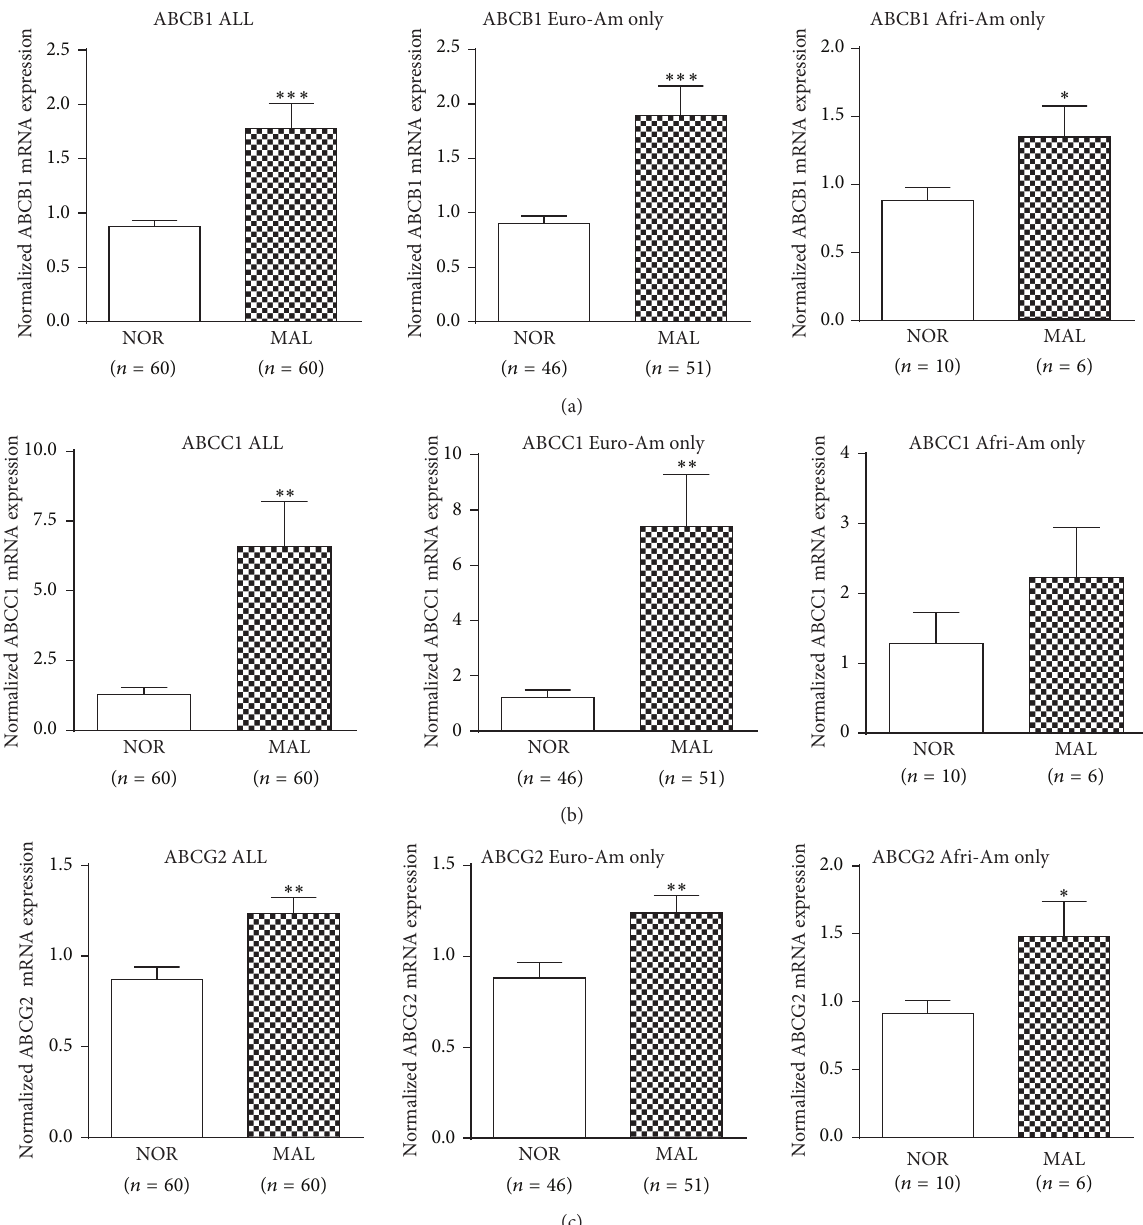
Figure 1: Comparison of ABCB1, ABCC1, and ABCG2 gene expression in normal and pancreatic cancerous tissue. The individual expression levels of the indicated ABC transporters (a–c) were analyzed by real-time qRT-PCR, normalized to mRNA expression of PMM1, and reported as x-fold relative to the expression of a calibrator (a premixed pancreatic RNA sample, set as 1). Values are expressed as means ± SEM, ∗ 𝑃 < 0.05 , ∗∗ 𝑃 < 0.01 , and ∗∗∗ 𝑃 < 0.001 . Euro-Am, European Americans; Afri-Am, African Americans.